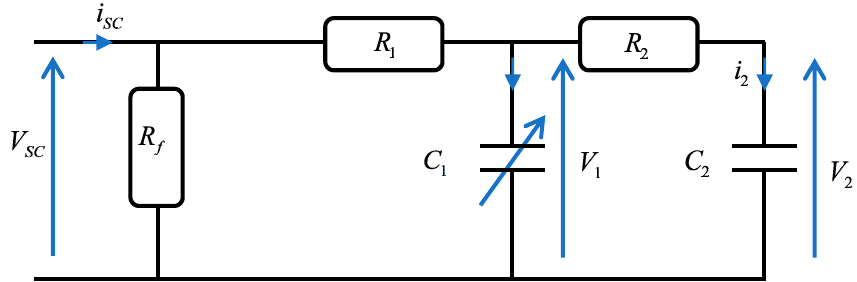
Figure 4. Supercapacitor simplified circuit: two-branch model.